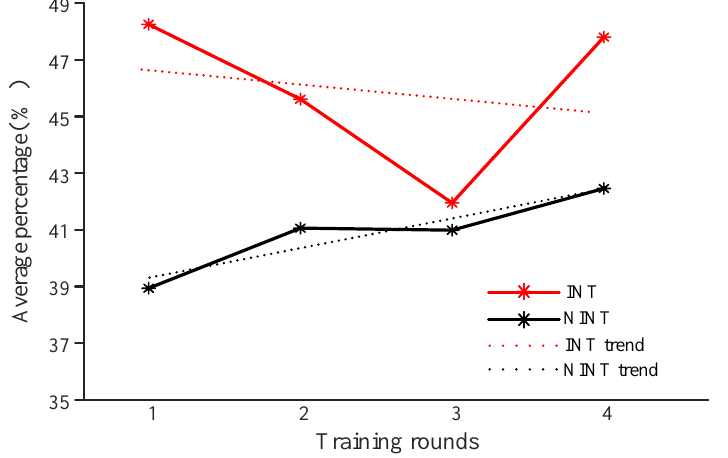
Figure 5. Proportion statistics for the Oxy-Hb concentration levels higher than the threshold resulting from the neurofeedback training.